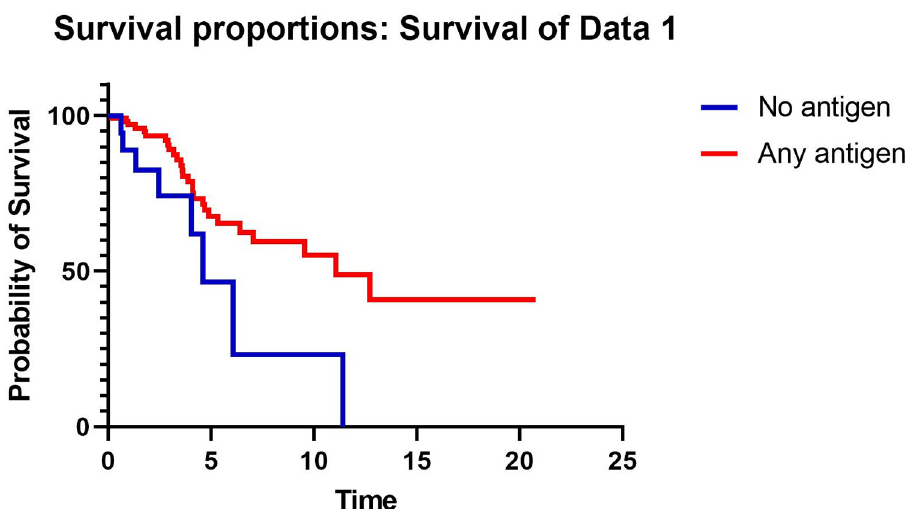
Fig 1. Kaplan-Meier curve comparing transplant-free survival in years in patients with no antigen identified vs at least 1 antigen identified.